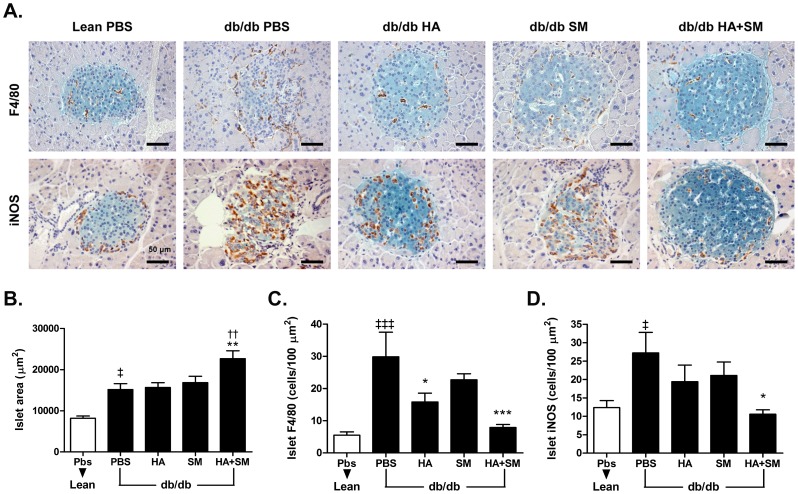
HA+SM increases islet area but reduces islet macrophage infiltration and expression of iNOS protein.
A. Representative images of the islets from each treatment group. β-cells are visualised by staining with anti-insulin antibody (green), with either F4/80+ macrophages (upper panel) or iNOS positive cells (lower panel) stained in brown. Scale bars represent 50 µM. Quantification of B. islet cross-sectional surface area; and number of C. F4/80+ macrophages or D. iNOS+ cells per unit islet area in each treatment group. ‡P<0.05, ‡‡‡P<0.001 v lean PBS, *P<0.05, **P<0.01, ***P<0.001 v db/db PBS, ††P<0.01 v db/db HA. P-values derived from Bonferroni’s multiple comparison post-test when P<0.05 by one-way analysis of variance. The data are mean ± s.e.m from n>25 islets/mouse.